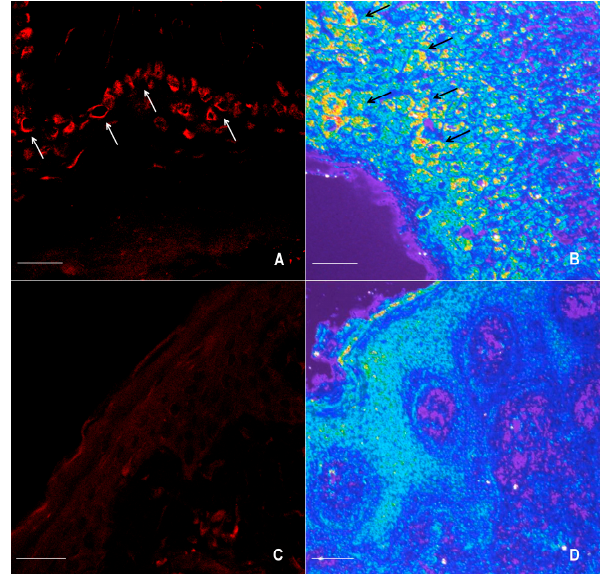
Figure 1. Normal skin: immunofluorescence staining of nNOS and iNOS ( A , B ). Confocal images obtained in “overlay” mode showed nNOS expression (arrows) in the sections ( A , B ); iNOS expression was not detected ( C , D ). The confocal image was “colored” and superimposed on a transmission image of the same skin area to show the exact localization of the reaction. Argon laser (568 nm) lens 3, zoom 1, original magnification 40×. ( A , B ) bar = 25 µm; ( C ) bar = 250 µm; ( D ) bar = 100 µm.